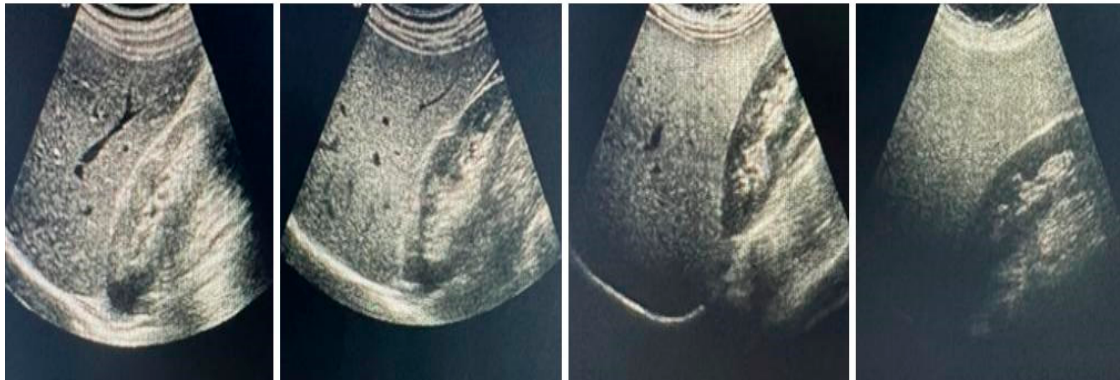
Figure 1. Ultrasonography findings in hepatic steatosis. Liver with no increase in echogenicity compared to kidney. From left to right; Fatty liver is excluded in the first picture, while mild, moderate and severe hepatic steatosis is seen, respectively [15].